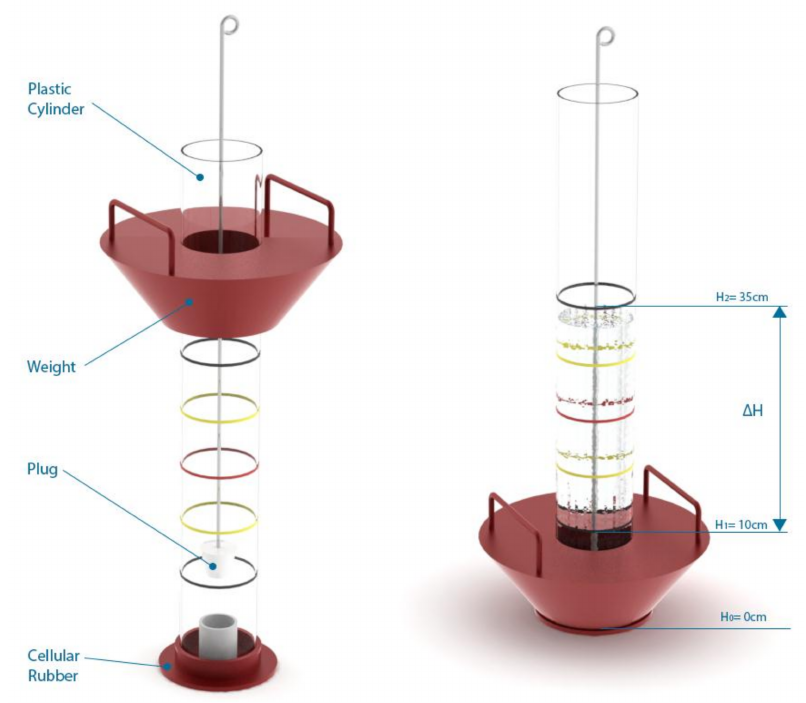
Figure 4. Laboratorio Caminos Santander (LCS) permeameter scheme and test set-up. Self-made based on